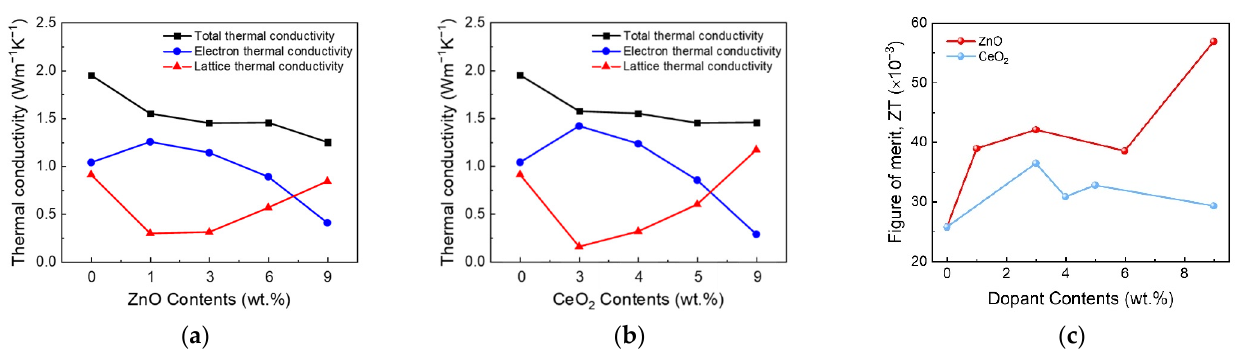
Figure 4. Dependence of the thermal conductivities of the ( a ) ZnO-doped ITO and ( b ) CeO 2 -doped ITO on the doping concentration. ( c ) Thermoelectric figures of merit (ZT) of ZnO- and CeO 2 -doped ITO. The lattice thermal conductivity increased above a certain doping concentration.